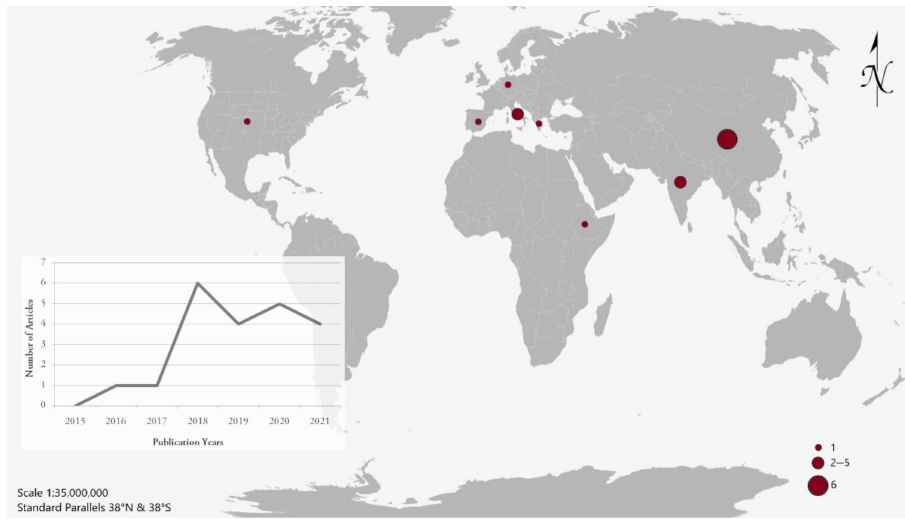
Figure 1. Selected articles for analysis grouped by country.